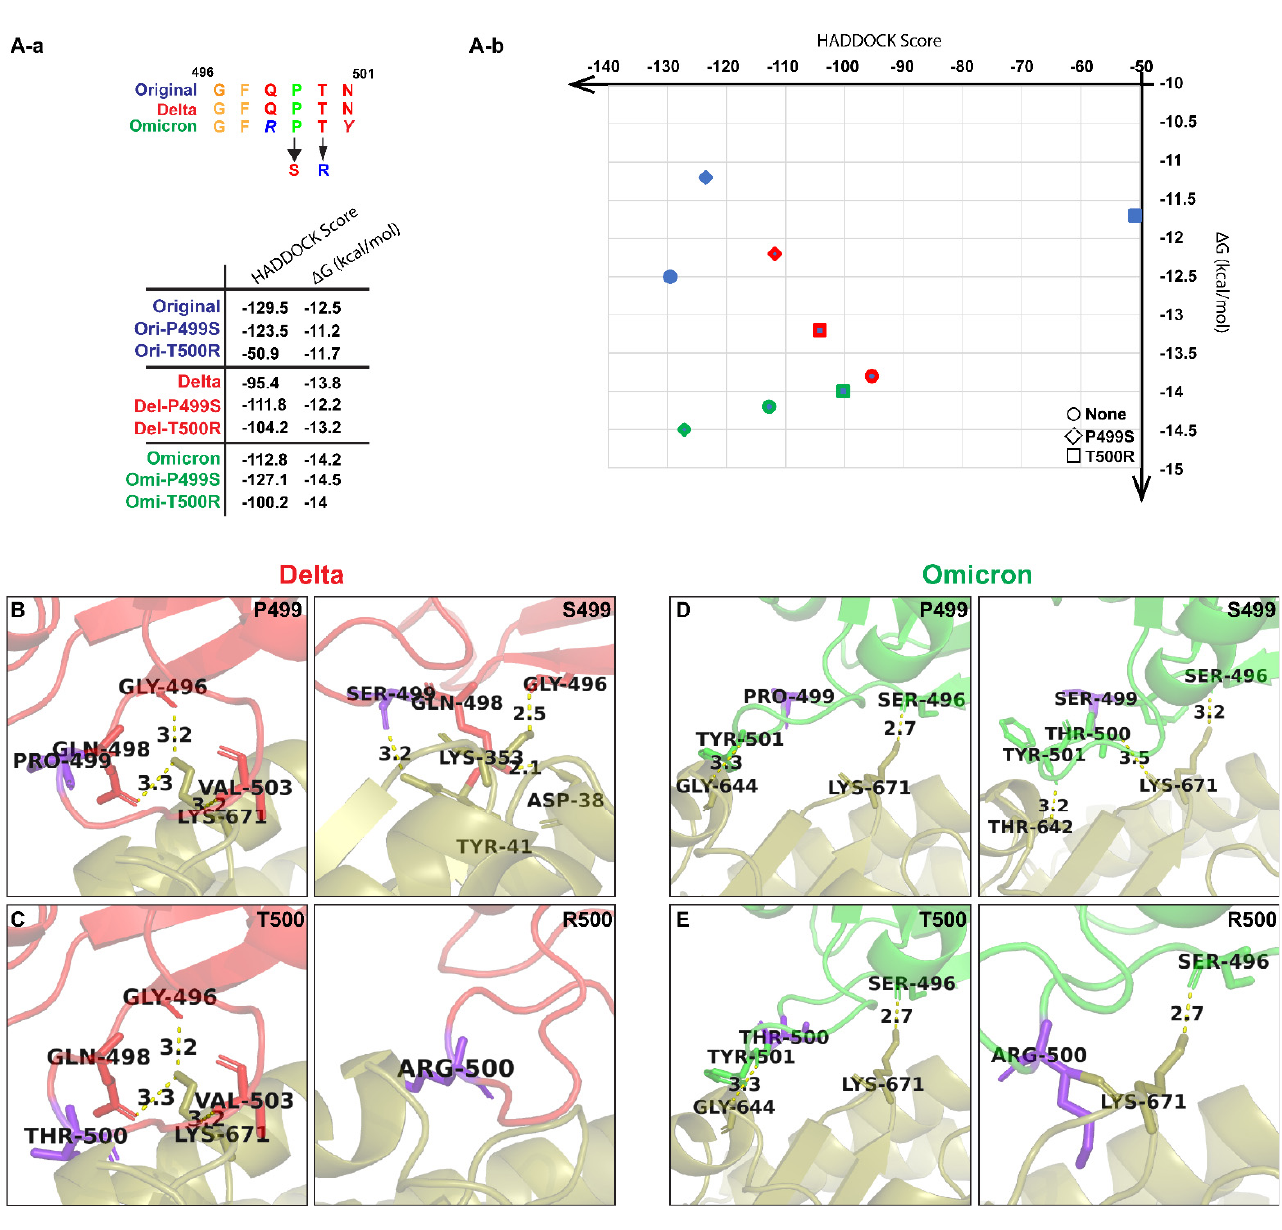
Figure 3. ( A-a ) Mutations in the RBM and the difference between their HADDOCK scores and binding affinity. ( A-b ) A distribution map of the scores obtained from HADDOCK and PRODIGY. ( B ) A cartoon representation of the interaction between P499 and S499 in the Delta RBD and the ACE-2 receptor. ( C ) A cartoon representation of the interaction between T500 and R500 in the Delta RBD and the ACE-2 receptor. ( D ) A cartoon representation of the interaction between P499 and S499 in the Omicron RBD and the ACE-2 receptor. ( E ) A cartoon representation of the interaction between T500 and R500 in the Omicron RBD and the ACE-2